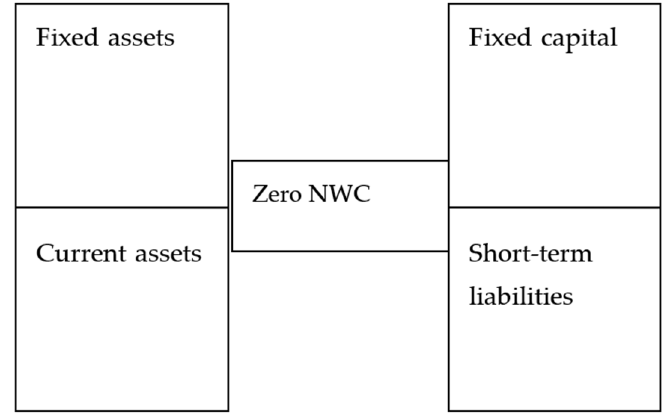
Figure 5. Zero working capital. Source: own research.